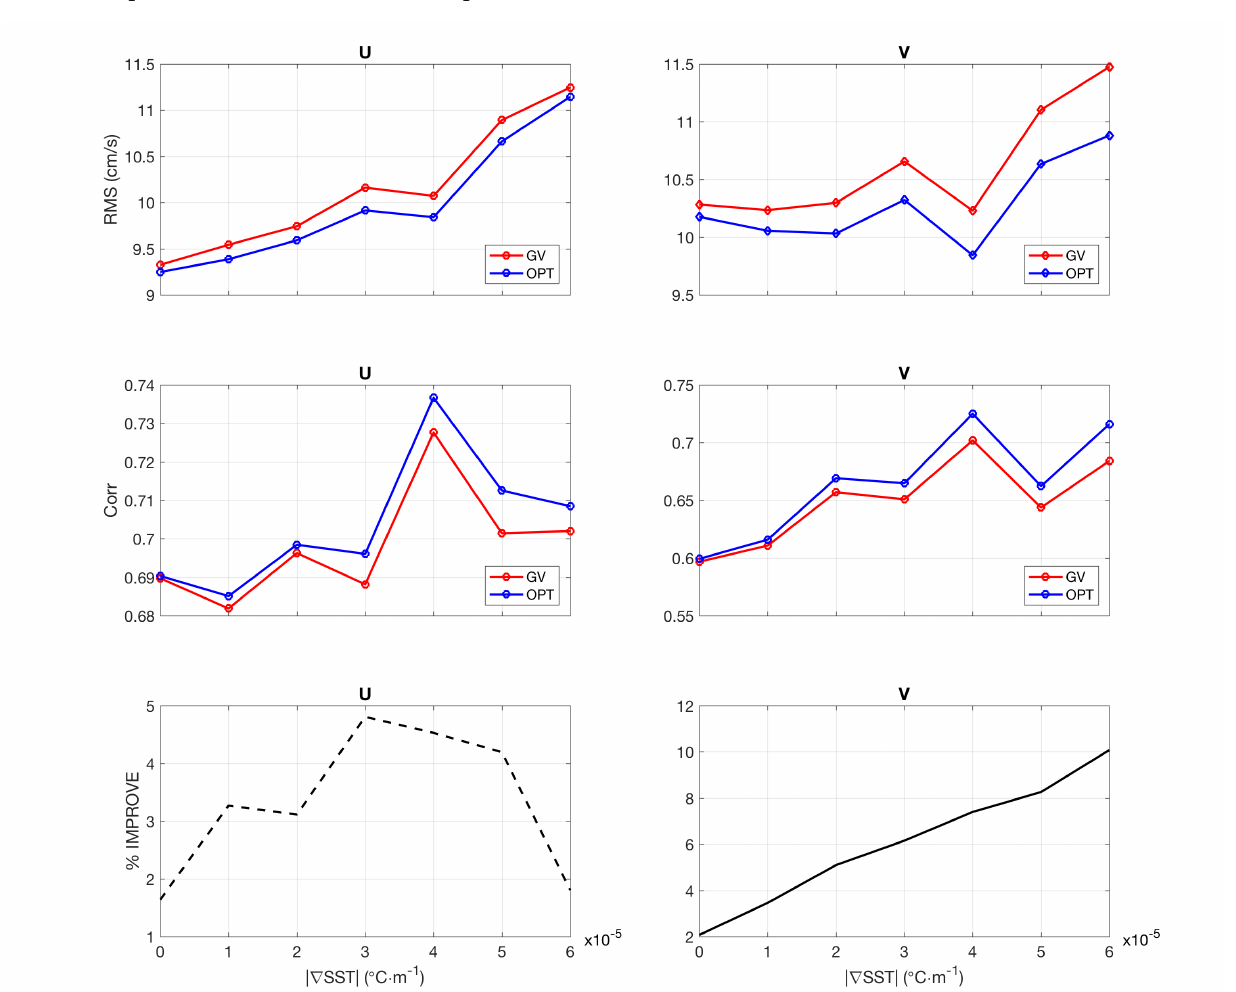
Figure 9. Basin scale improvements of the Optimal reconstruction method expressed via root mean square error (RMSE), Correlation Coefficients (Corr) and percentage of improvement (% IMPROVE) in the period 2012–2016. The Root mean square errors and correlation coefficients are computed for both the Optimal currents (blue lines) and the geostrophic velocities (GV) (red lines) using the drifting buoys-derived surface currents as a benchmark. The results are presented for both the zonal (U) and the meridional component (V) of the surface motion, respectively shown in the left and right column of the